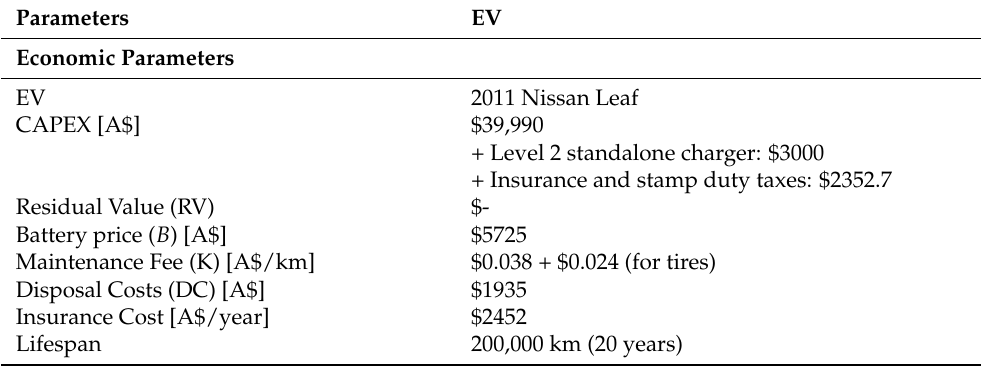
Table 5. Case study parameters of